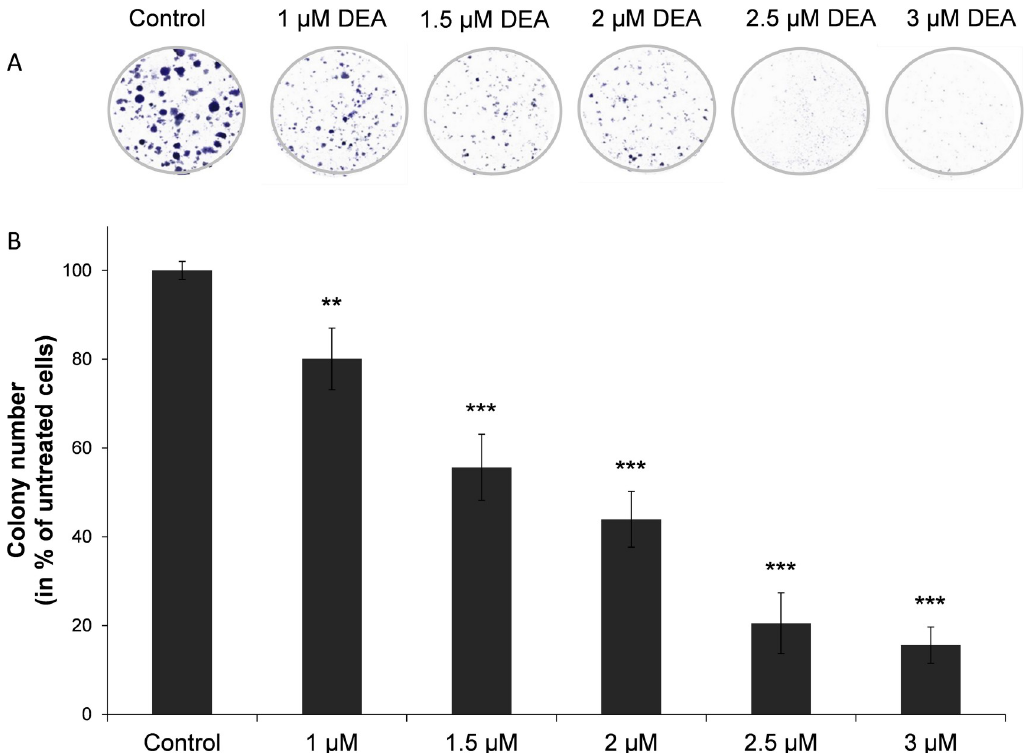
Fig 2. Effect of DEA on colony formation of B16-F10 murine melanoma cells. For the assay the cells were exposed to increasing concentrations of DEA for 7 days. The results are presented as representative images (A) and as a bar diagram (B). Controls were treated with vehicle (0.2% DMSO). The results are mean ± SD of three independent experiments performed in at least quadruplicate. Data were analyzed using ANOVA with Dunett post hoc test. �� p � 0.01 and ��� p � 0.001 compared to the control